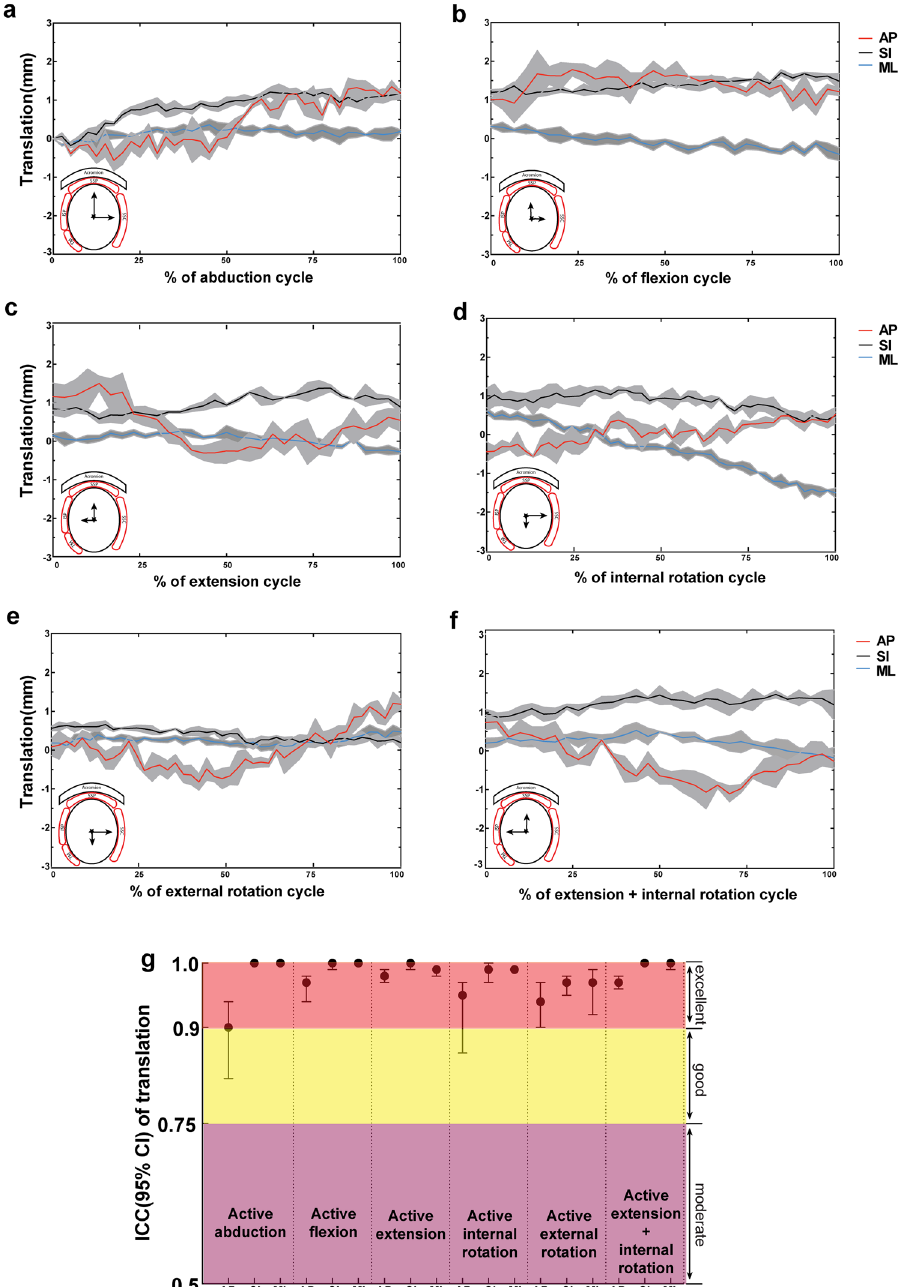
Figure 3. The glenohumeral translations (anterior/posterior, AP; superior/inferior, SI; medial/lateral, ML) during active abduction ( a ), flexion ( b ), extension ( c ), internal rotation ( d ), external rotation ( e ) and extension&internal rotation ( f ) cycles (Data from specimen 2). The grey areas represent standard deviations. The intraclass correlation coefficient (ICC) of AP, SI and ML translations over the repeated motions are delineated ( g ) (Data from all three